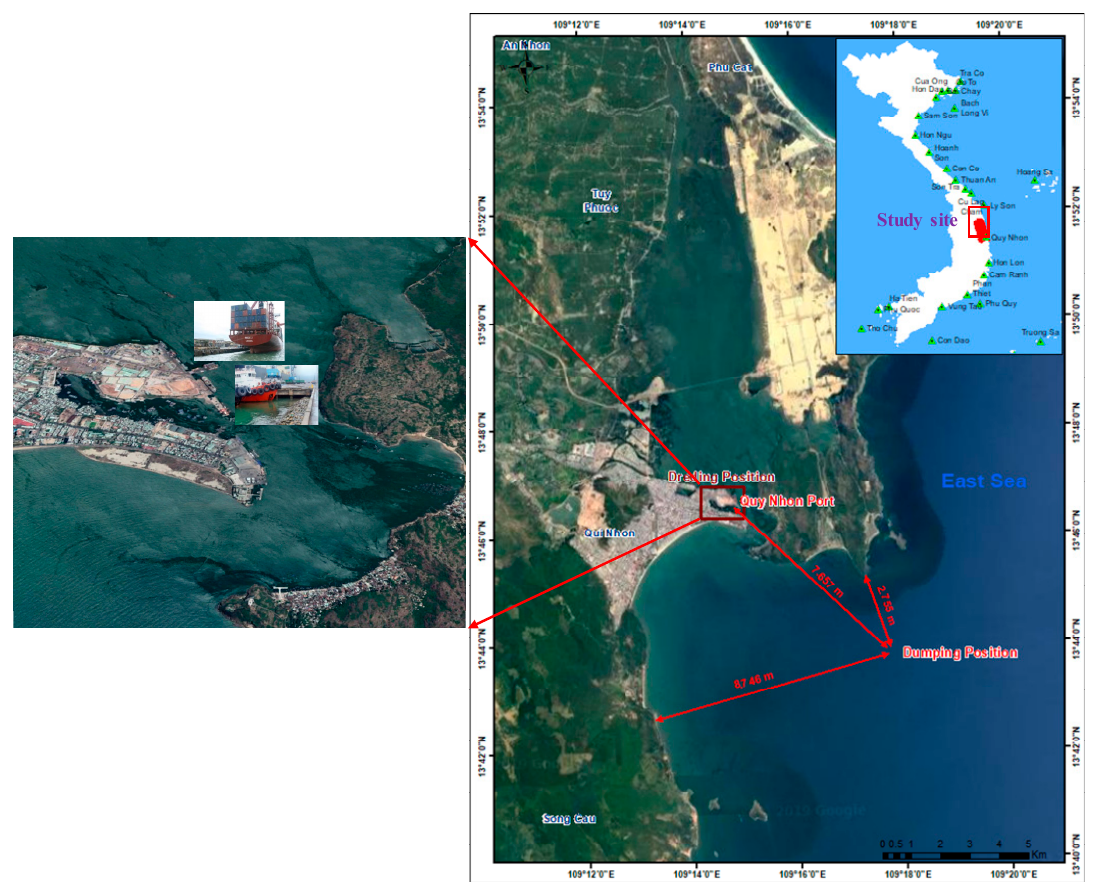
Figure 1. Location of study area (Quy Nhon Port, 2012).